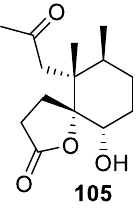
Figure 46. Abiespiroside A isolated from Chinese tree Abies dalavayi .